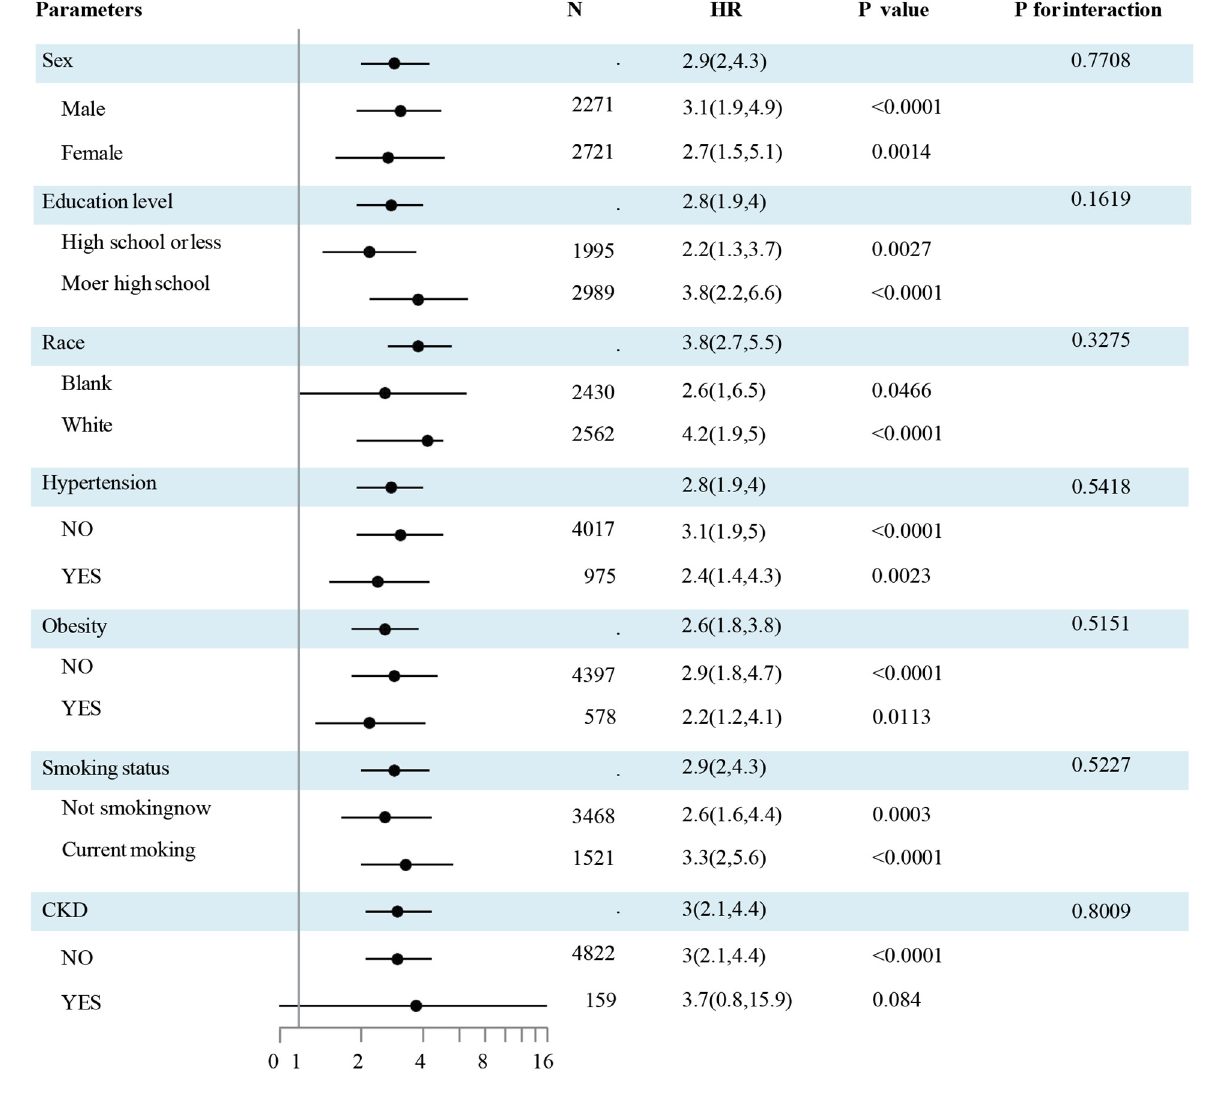
FIGURE 3 | The association of CHF and the TyG index by a subgroup analysis. The association of CHF and the TyG index by a sub-group analysis. Data are hazard ratios (HRs) and 95% confidence limits (95% CLs). The participants were divided into subgroups according to sex, race, education, obesity, smoking status, hypertension, and CKD. The results were evaluated after adjusted for age, sex, race, education, obesity, smoking status, hypertension, diabetes mellitus, hypercholesteremia, CKD, LDL-C, and HDL-C except for the sub-group variable. Abbreviations: HDL-C, high-density lipoprotein cholesterol; LDL-C, low-density lipoprotein cholesterol; TyG, Triglyceride-glucose; CKD, chronic kidney diseases; HOMA-IR, homeostasis model assessment-insulin resistance; CHF, congestive heart